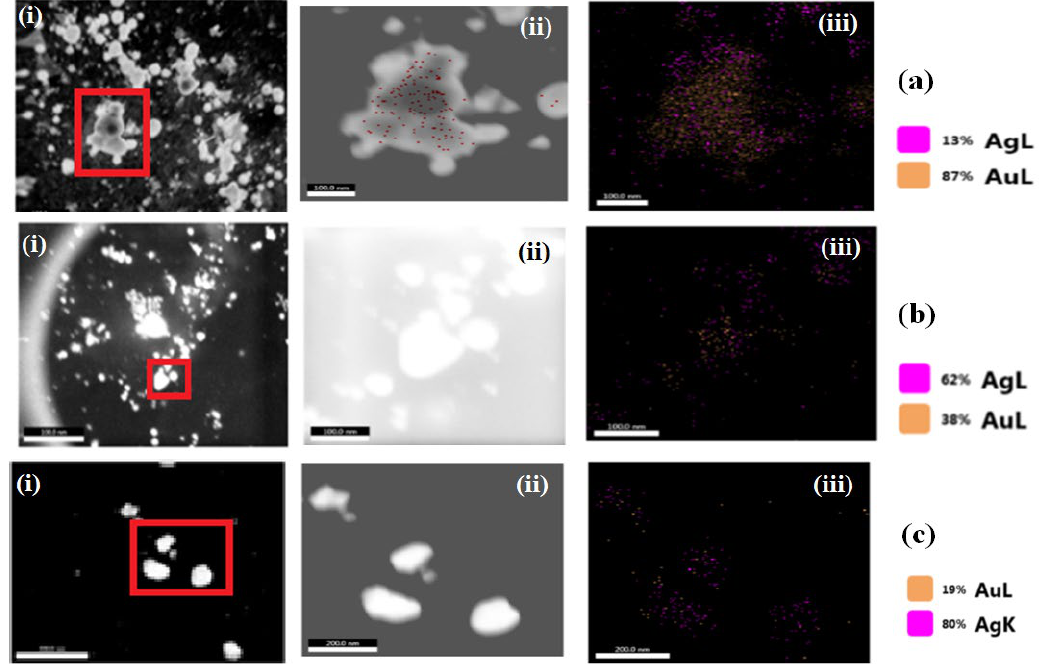
Fig. 3. Scanning TEM (STEM) image of the as-synthesized Au-Ag alloy NPs energy dispersive X-ray (EDX) elemental maps of (a) Au75: Ag25 and (b) Au50:Ag50 and (c) Au 25: Ag